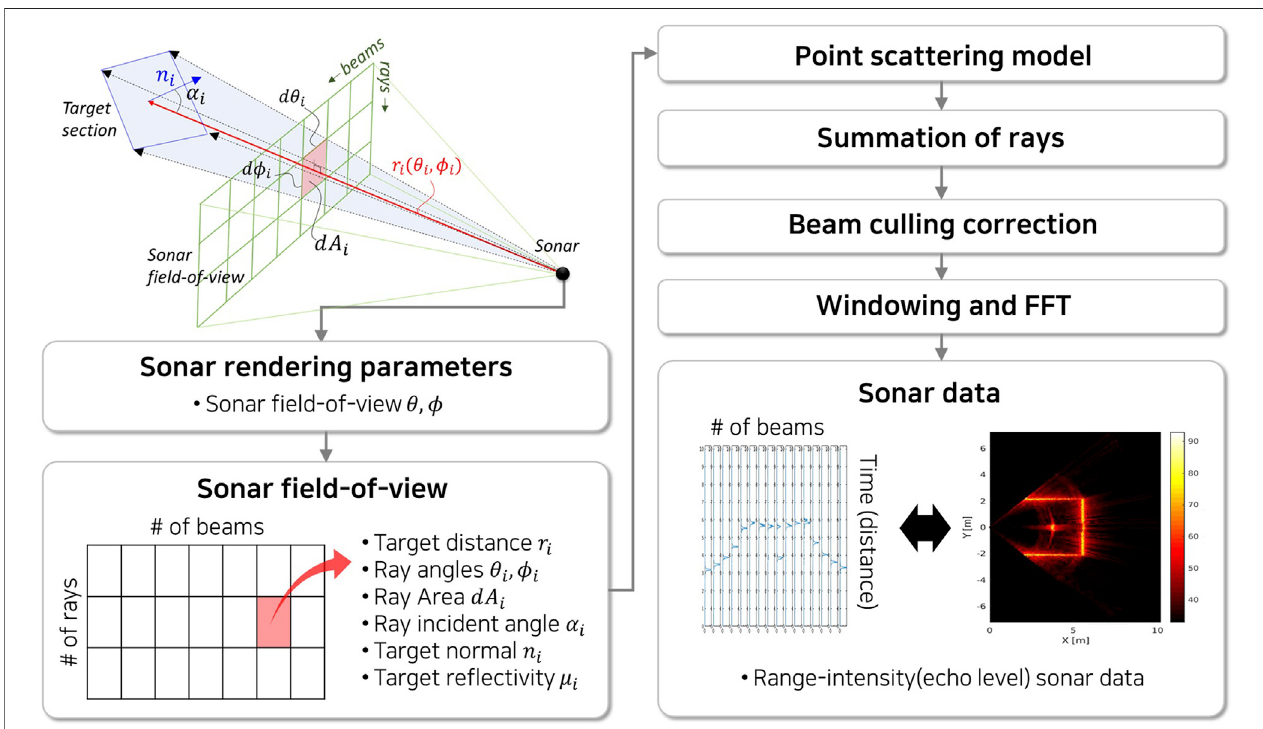
FIGURE 5 | Overall procedures of the imaging sonar simulation process: (i) a Gazebo camera plugin obtain the underwater scene; (ii) two dimensional set of sonar fi eld-of-viewdatacapturedintherenderingscene;(iii)pointscatteringmodeliscalculatedforeachraydata(iv)summationofraystoeachbeam;(v)beampatterneffectis calculated for beams; (vi) and the windowing and fast-fourier transform (FFT) is performed to produce range-intensity sonar data for each beam.